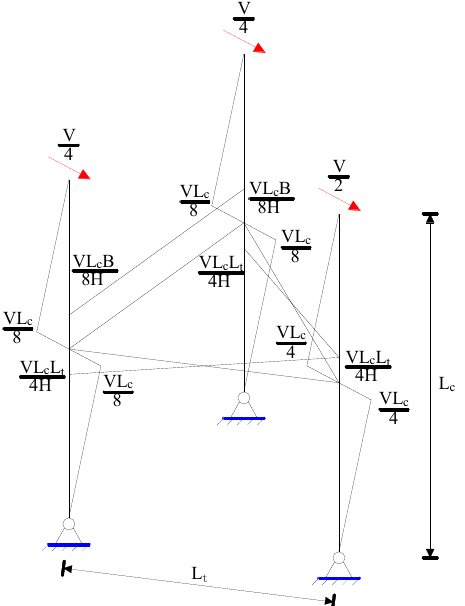
Figure 6. Distribution of bending moments of a segment under shear force 𝑉 .